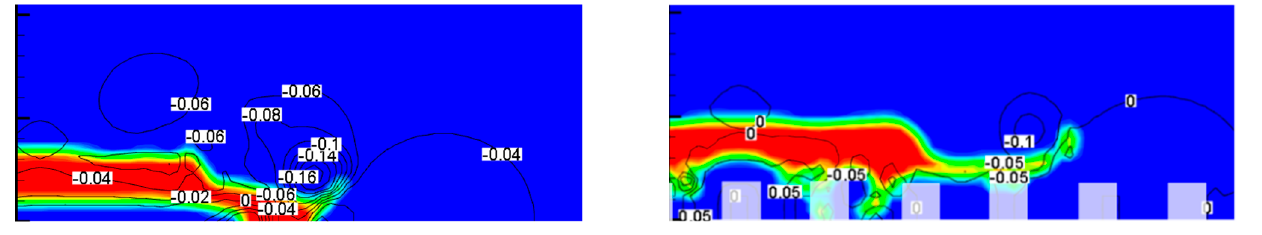
Figure 18. Pressure field at t* = 2.5.